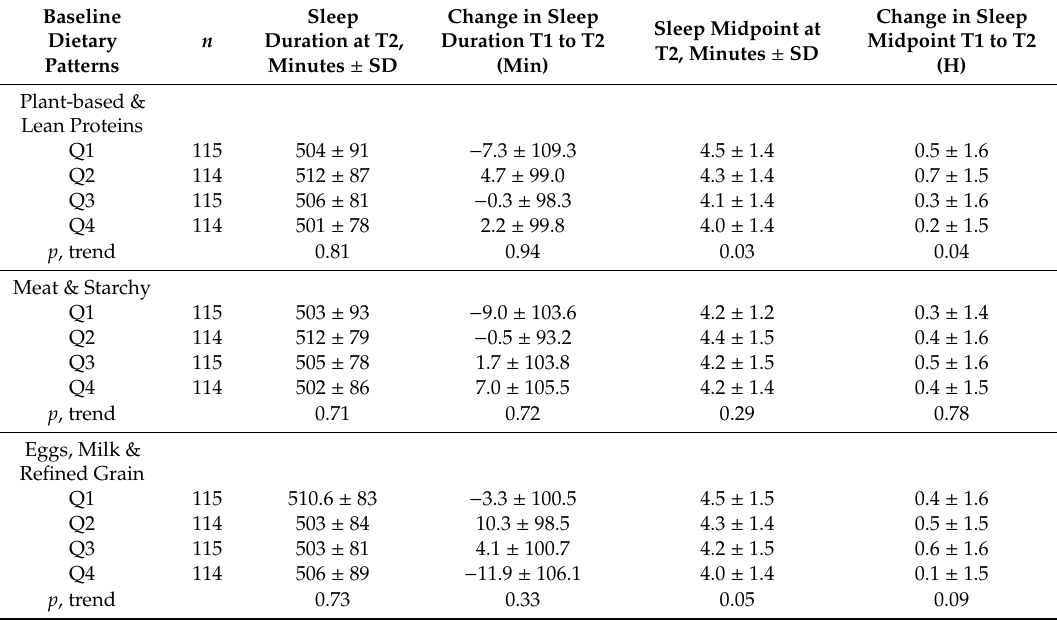
Bivariate associations between baseline dietary patterns and prospective weekday sleep